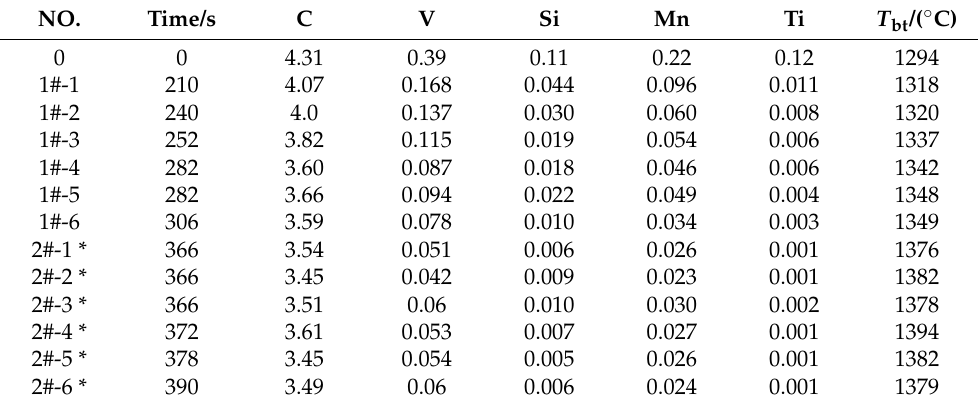
Table 3. The molten bath temperatures and molten iron compositions (wt%) in various time during industrial experiments.